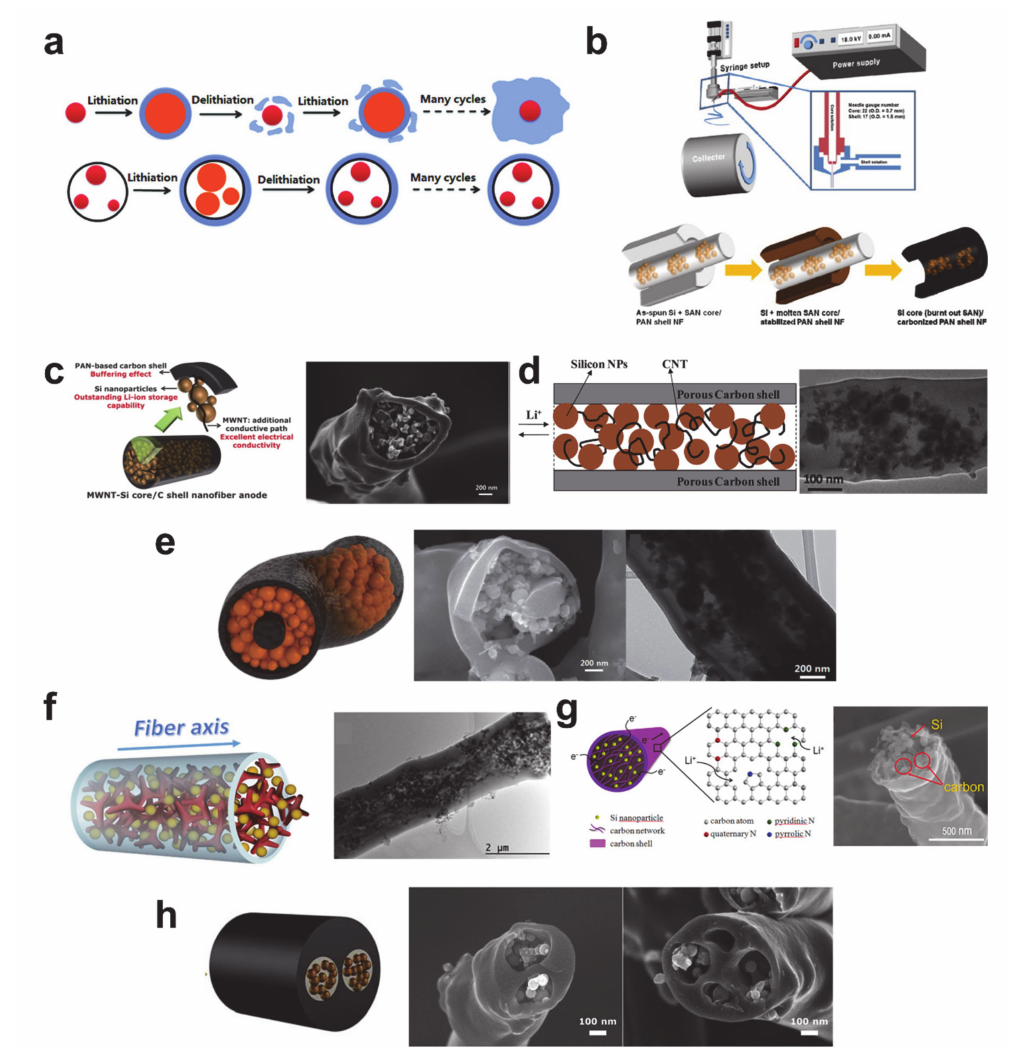
Figure 21. Hollow carbon nanofiber anode materials containing silicon nanoparticles in void space. ( a ) Schematic diagram of structural change and solid electrolyte interphase growth on the raw